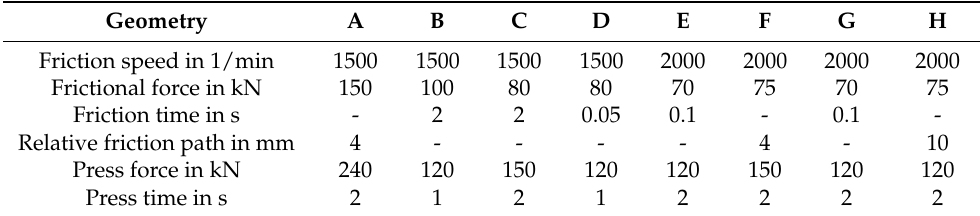
Table 3. Main parameters of the friction welding process.